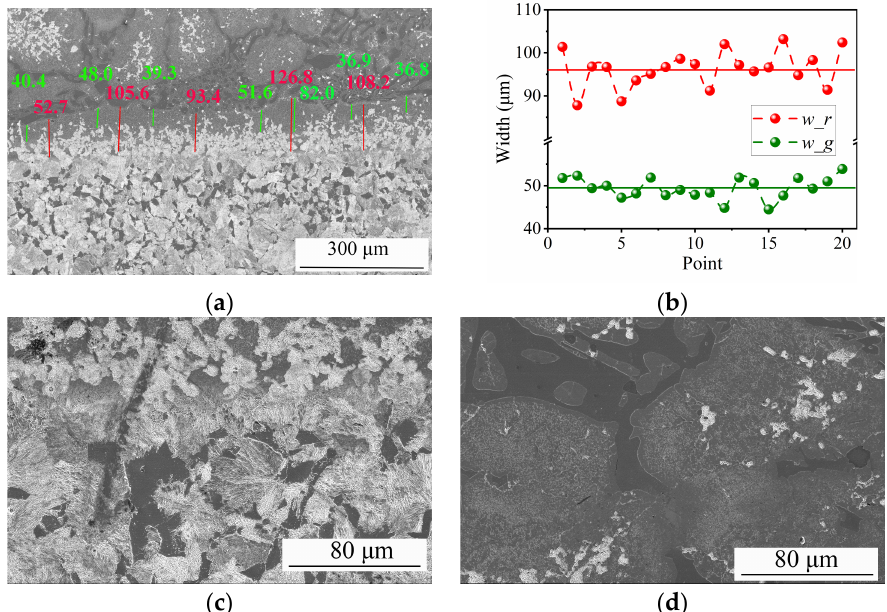
Figure 13. Microstructure near the interfacial region of specimen S2 ( a ) around the interface, ( b ) measured interfacial width data and average values, ( c ) the LAS side, and (d) the HCCI side. ( c ) and ( d ) are enlarged parts of ( a ).